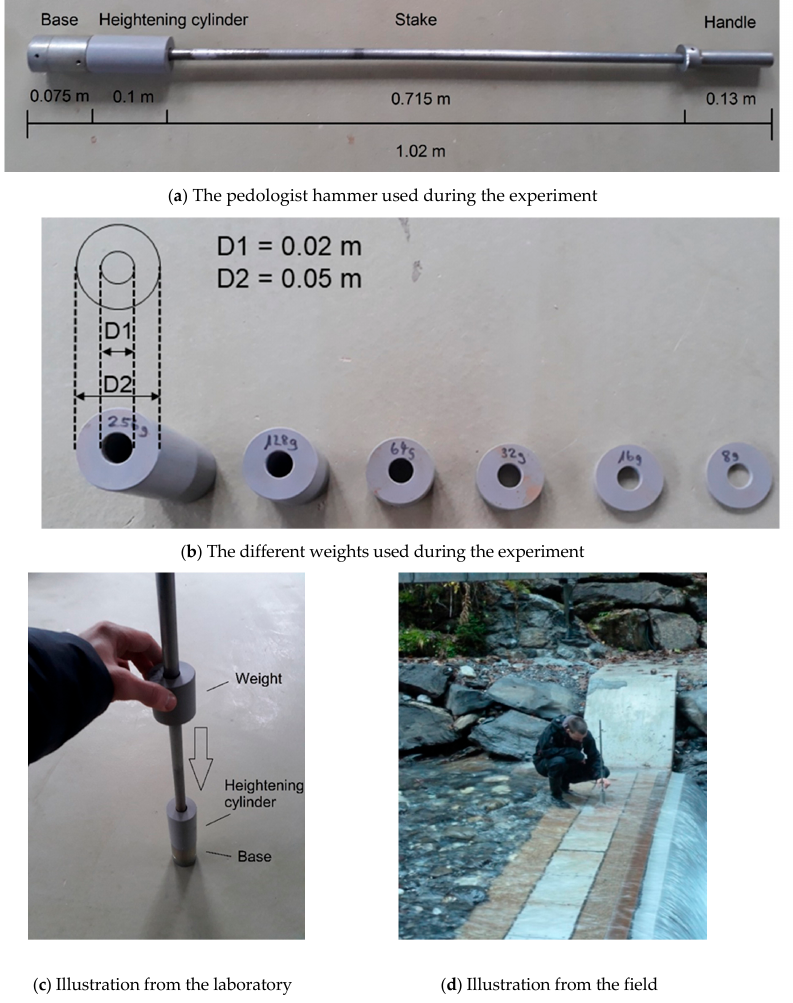
Figure 1. Set up of ( a ) the pedologist hammer, ( b ) the weights used for the experiment, ( c ) illustration of the experiment in the laboratory and ( d ) in the field. The setting of the impact experiment developed in this paper also includes some sources of uncertainty. Both the surrounding air and the potential friction of the weight along the stake on the way down can affect the delivered energy. In addition, the propagation of the energy from the weight to the plate through the base can increase the variability in the transmitted energy for an impact assumed to be of same magnitude. Therefore, an initial laboratory experiment was performed to